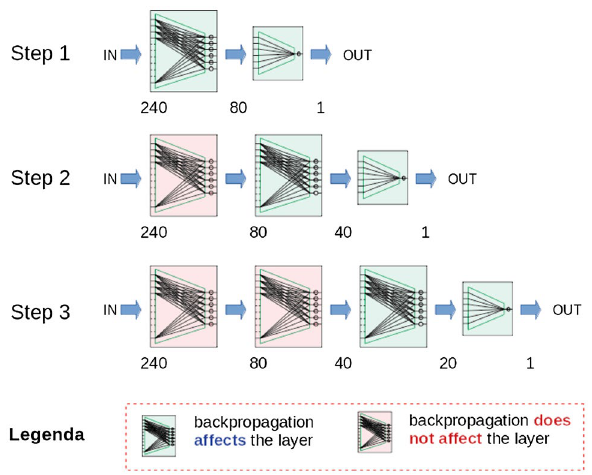
Figure 11. Snapshot of PT applied to an MLP equipped with three hidden layers (240 inputs, one output, and three hidden layers with 80, 40, and 20